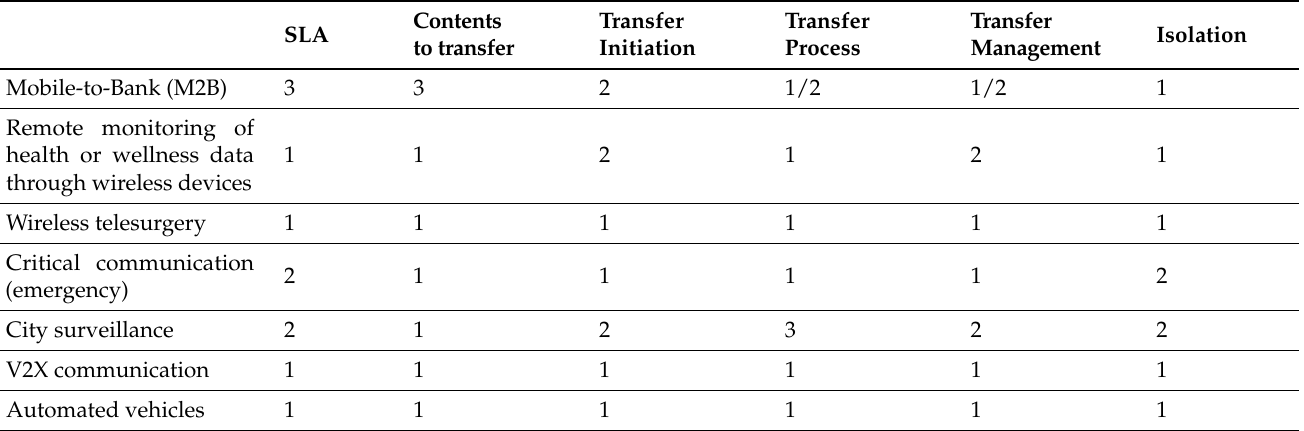
Table 14. The importance of the